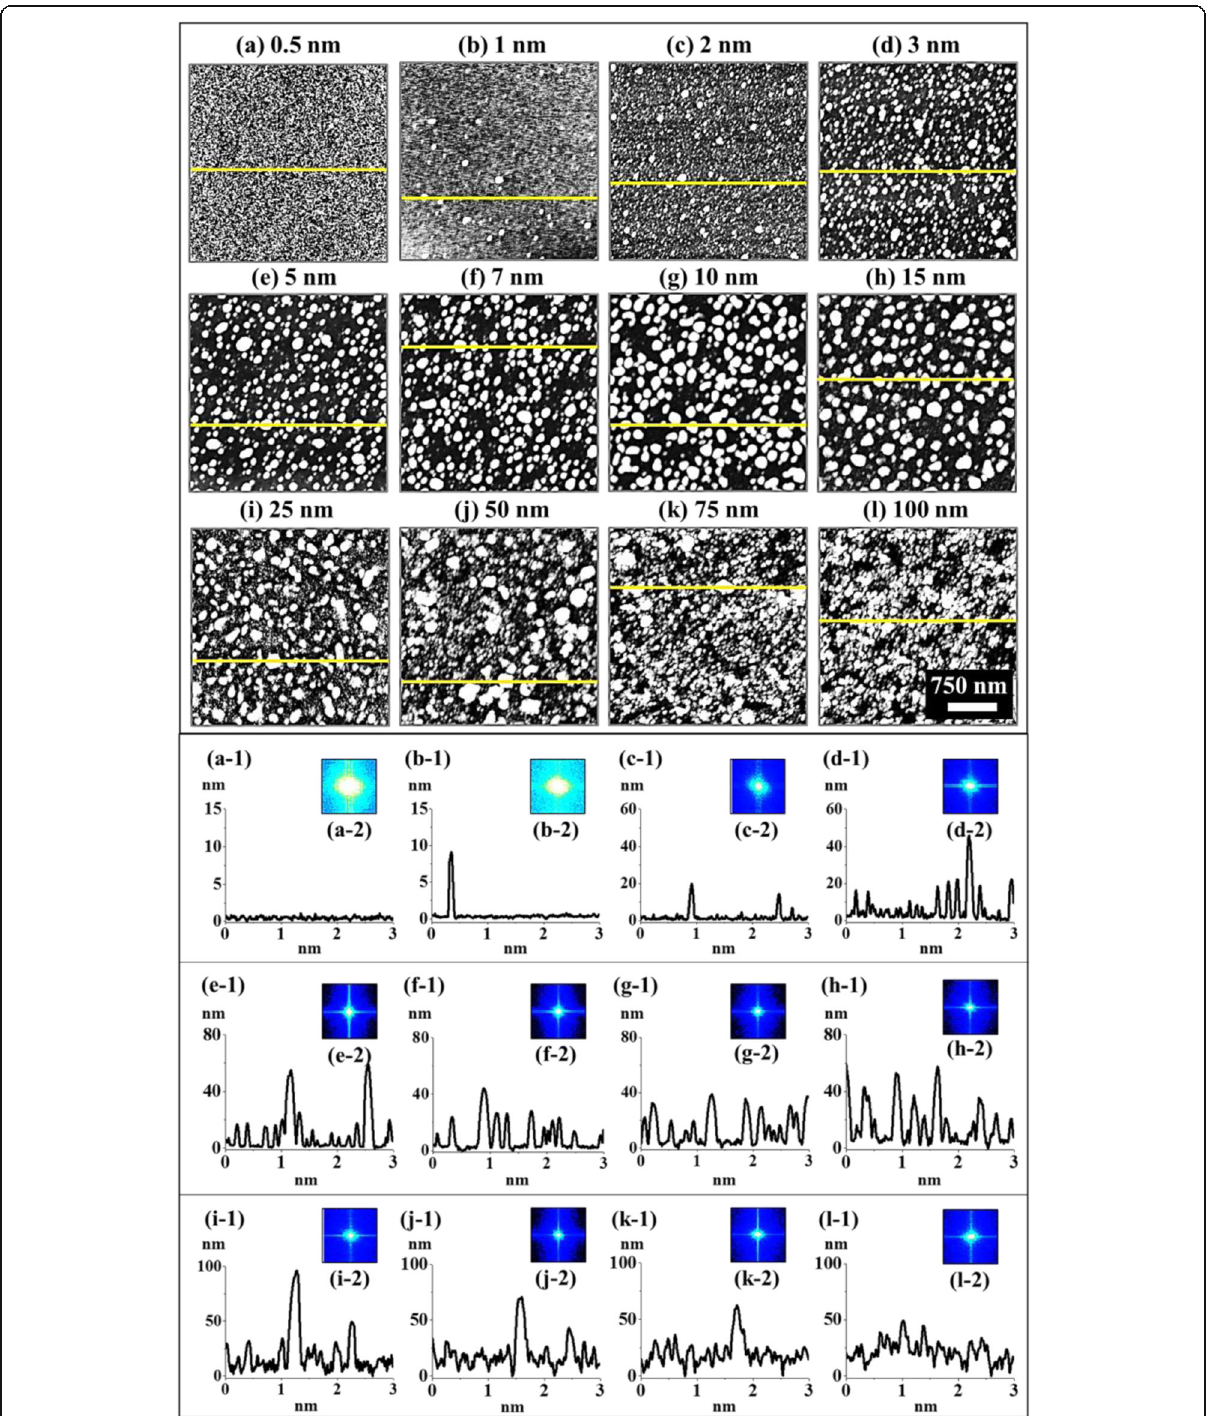
Fig. 1 Pd nanostructures evolution on Si (111) by the variation of deposition amount between 0.5 and 100 nm via constant annealing at 575 °C for 450 s. AFM top-views of 3×3 μ m 2 shows the a – c nucleation of small Pd grains, d – f growth of Pd nanoparticles (NPs), g , h lateral evolution of Pd NPs, namely, formation of elongated Pd nanostructures, and i – l merged nanostructures. a - 1 – l - 1 Cross-sectional line profiles of AFM images. a - 2 – l - 2 Corresponding Fourier filter transform (FFT) spectra of AFM